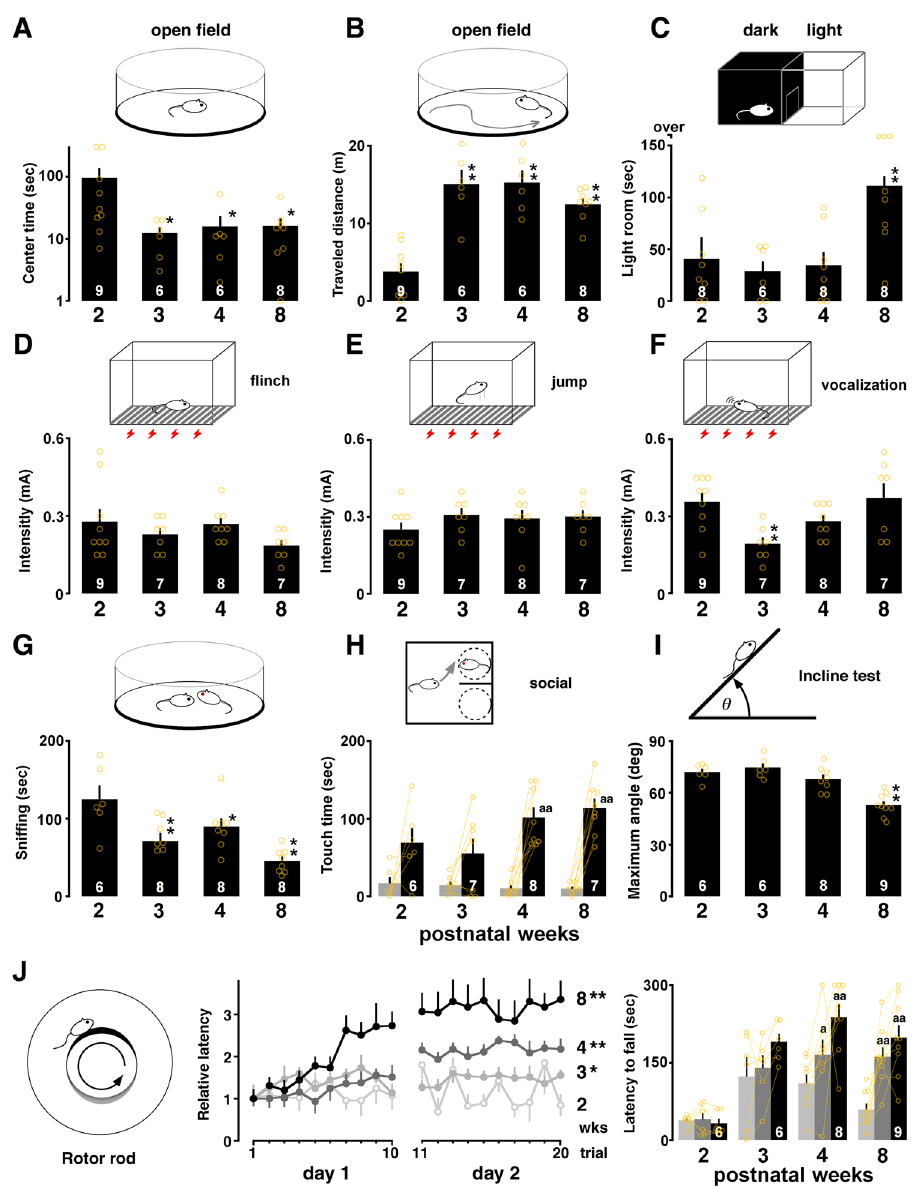
Figure 5. Postnatal changes in the emotional state and sensory/motor functions. ( A ) The latency in the center circle in the open field test was shorter at 3–8 weeks than it was at 2 weeks. ( B ) The traveled distance was longer at 3–8 weeks than it was at 2 weeks. ( C ) The time spent in the lit chamber in the light–dark box test was longer at 8 weeks than it was at 2 weeks. ( D , E ) In the sensory test, the current intensity for the flinch or jump was not changed. ( F ) The current intensity for vocalization was low only at 3 weeks. ( G ) The sniffing time of others in social interaction was shorter at 3–8 weeks than it was at 2 weeks. ( H ) Exposure to a social target significantly increased touch time at 4–8 weeks. ( I ) The maximum angle to fall in the incline test was steeper at 2–4 weeks than it was at 8 weeks. ( J ) Relative latency to fall from the barrel plotted for each trial (10 trials/day) at 2–8 weeks. The bar graph showed mean latency at the first trial and the final trial on day 1 (10th trial) and day 2 (20th trial). The number of rats is shown at the bottom of each bar. Data are shown as individual points and are the mean ± SEM. * P < 0.05, ** P < 0.01 vs. 2 weeks. a P < 0.05, aa P < 0.01 vs.